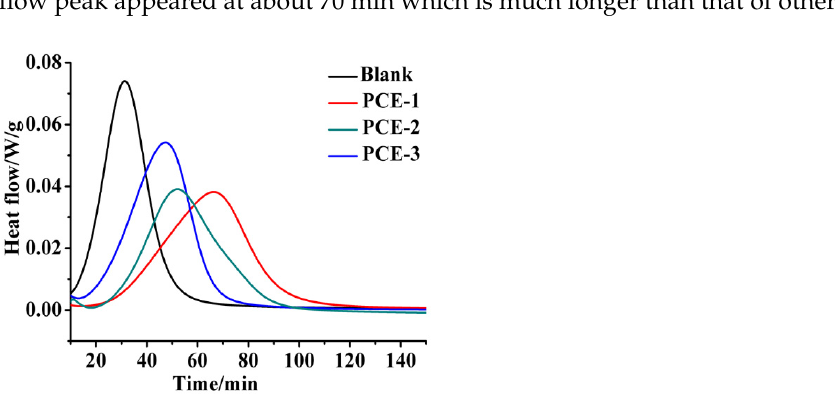
Figure 7. Schematic illustration of coordination between Ca 2+ and –COO − groups. ( A ) PCEs dis ‐ solved in β− HH; ( B ) PCEs adsorbed on the surface of β− HH particles.